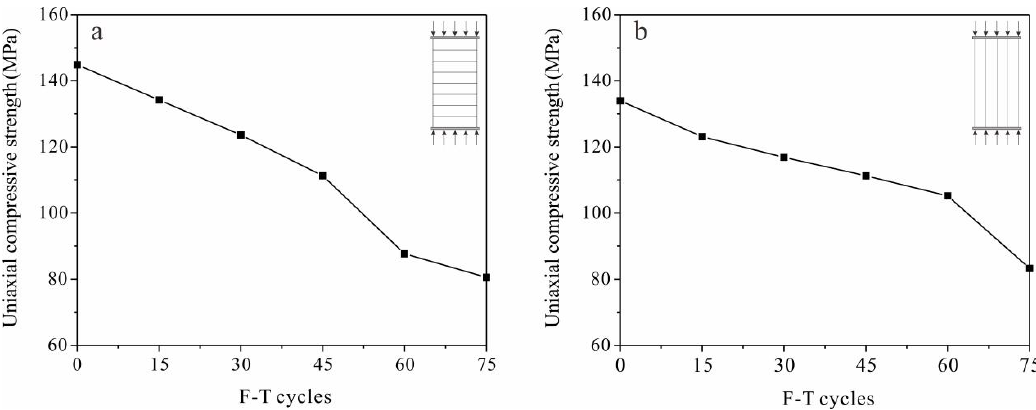
Figure 5. Uniaxial compressive strength with F-T cycles in sandstone loaded ( a ) perpendicular (S per ) and ( b ) parallel (S per ) to the bedding direction.